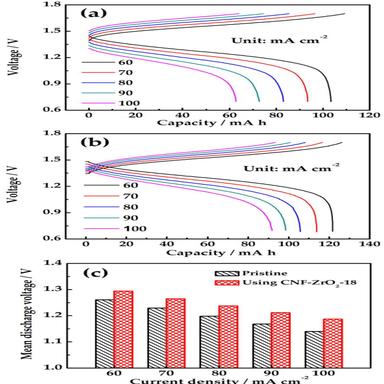
Charge-discharge curves of the cells without (a) and with (b) CNFeZrO2-18, and comparison of mean discharge voltage at various current density (c).